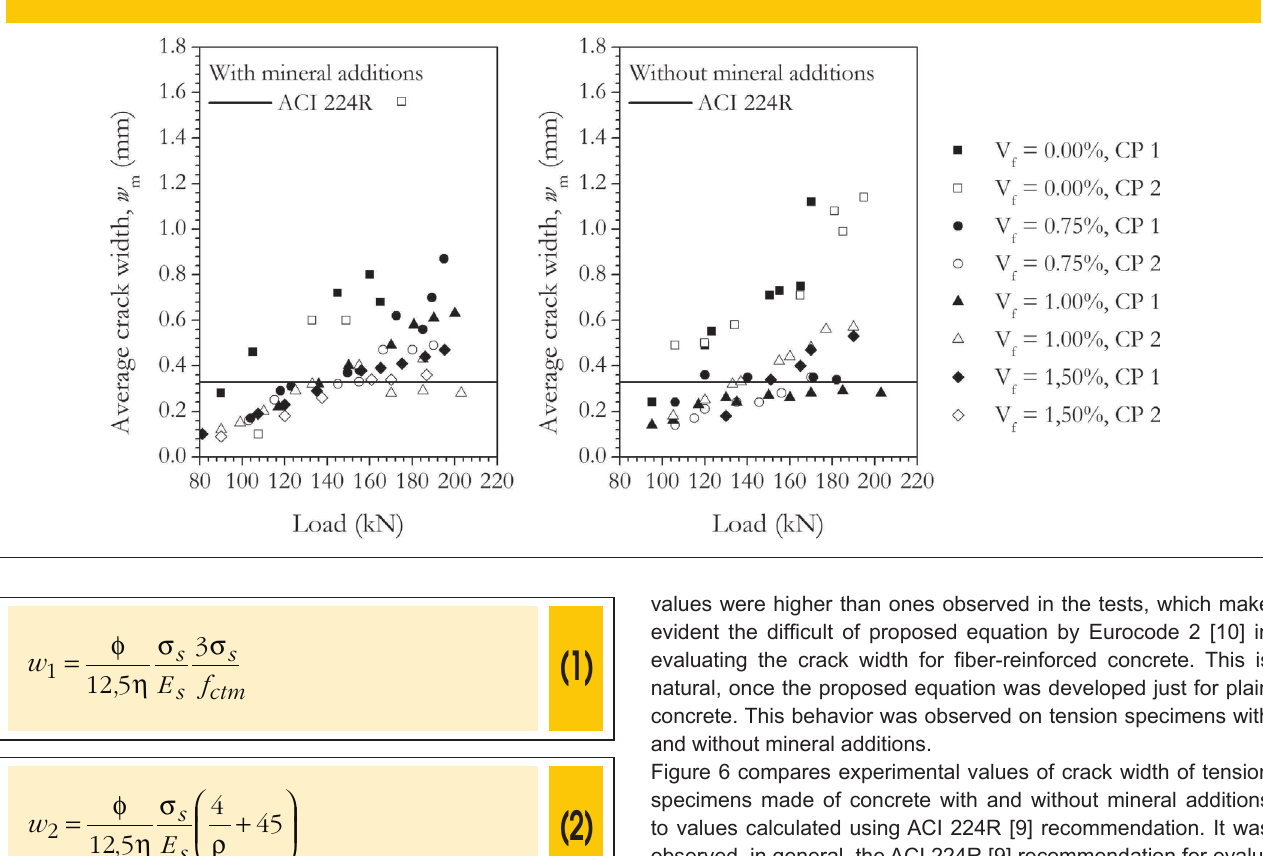
Figure 6 – Average main crack width – comparison between experimental and calculated according to ACI 224R values for concretes with and without mineral